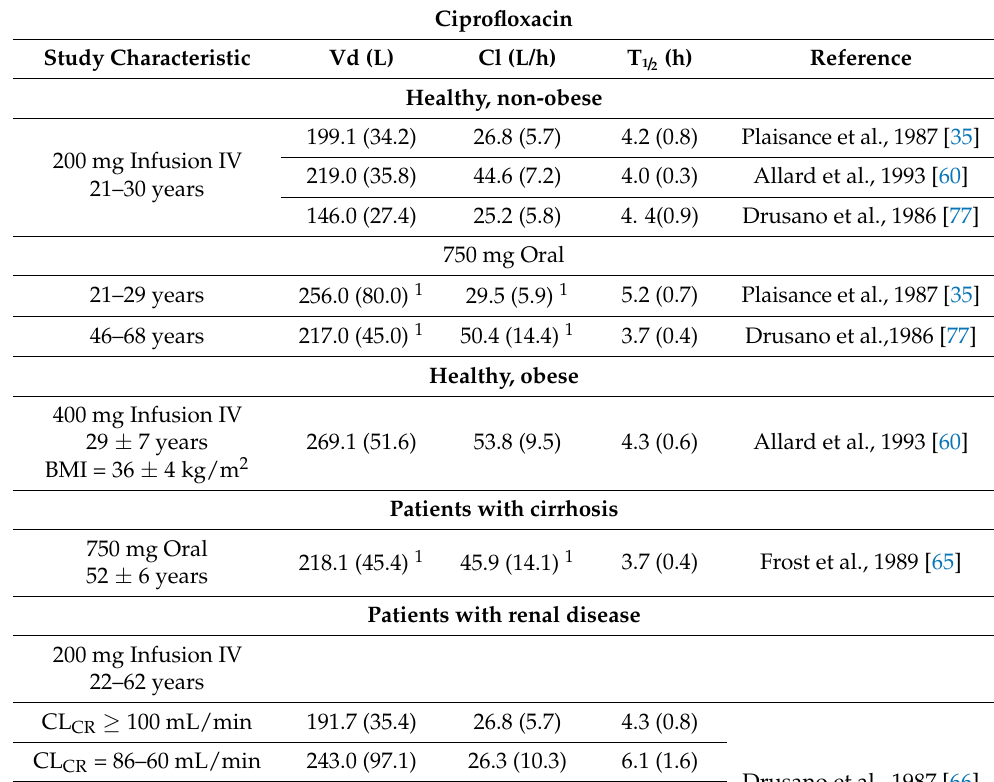
Table 1. Steady-state pharmacokinetic parameters for ciprofloxacin in patients with several physiopathology conditions after intravenous or oral administration (values expressed as mean (standard